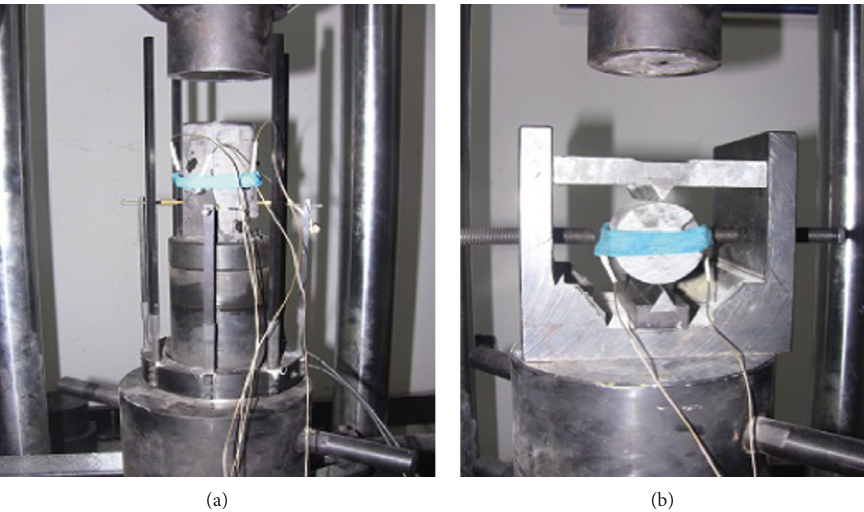
Figure 3: Splitting experiment and uniaxial compression: (a) uniaxial AE test and (b) shear AE test.